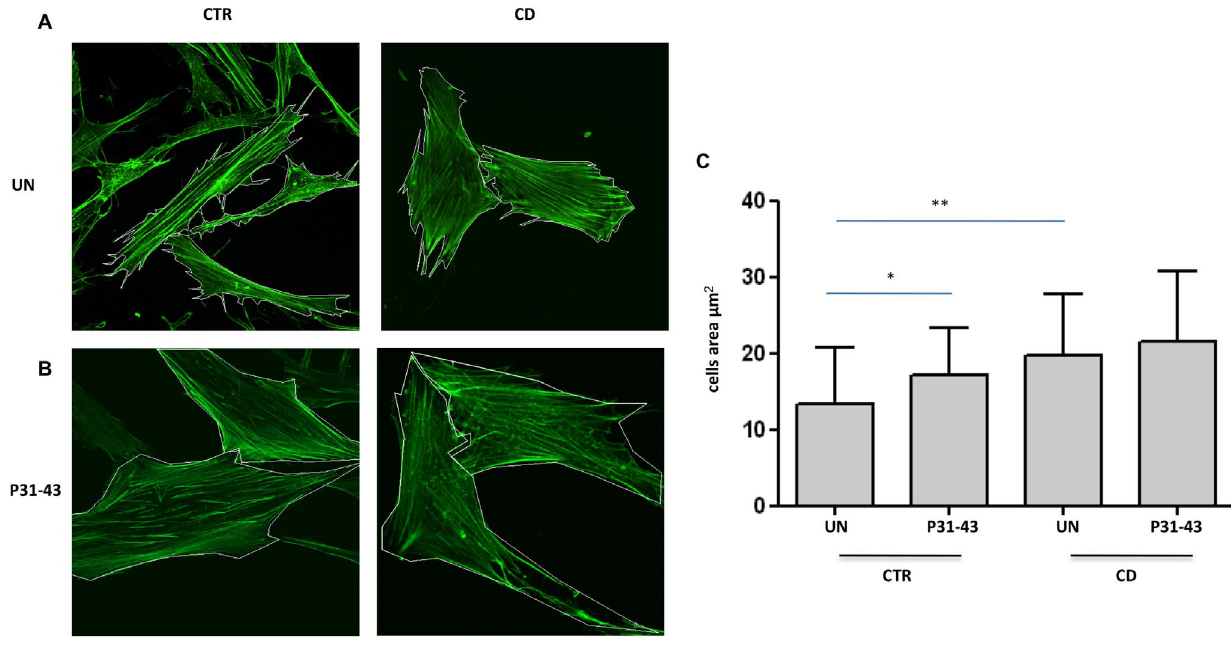
Figure 1. Cell shape and area of fibroblasts from CD patients and controls before and after P31-43 treatment. A. Cell shape and area are altered in fibroblasts from CD patients with respect to controls (CTR). Confocal immunofluorescence images of fibroblasts from CD patients and controls stained with Phalloidin-FITC to highlight F-actin. White lines identify the cell area. Representative fields. B. Treatment with P31-43 alters the shape and area of control fibroblasts. Confocal immunofluorescence images of fibroblasts from CD patients and controls treated with P31-43 for 30 min and stained with Phalloidin-FITC to highlight F-actin. White lines identify the cell area. Representative fields. C. Statistical analysis of 30 fibroblasts from several fields of 3 independent experiments from 6 patients and 6 controls. The area of the cells was analyzed using LSM-Zeiss confocal software. Columns represent the means, and the bars represent the standard deviation of the fibroblasts area. The area of the cells was analyzed using LSM-Zeiss confocal software. Columns represent the means, and the bars represent the standard deviation. Student’s t -test. *= p , 0.05; **= p , 0.01.